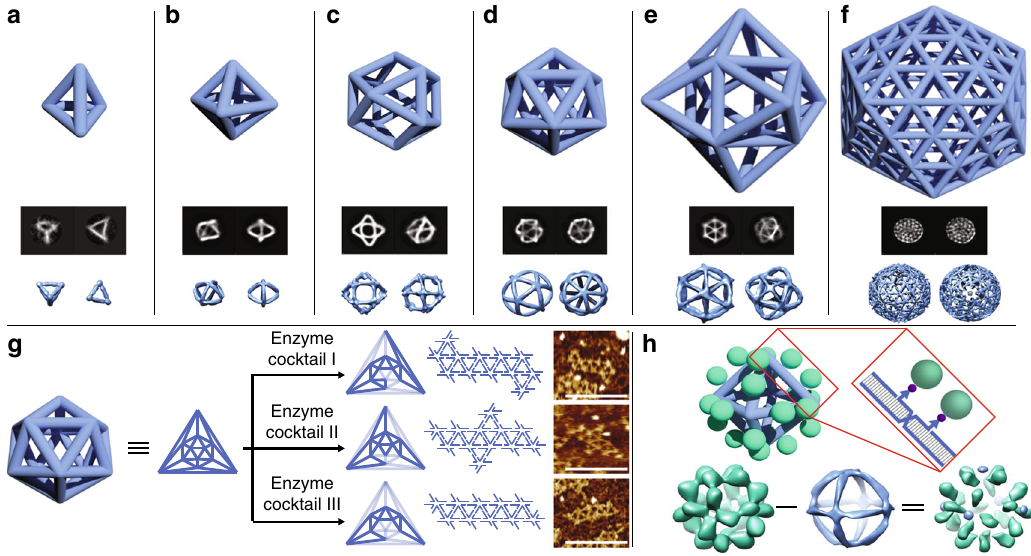
Fig. 4 Wireframe polyhedra. a Tetrahedron with 3-arm vertices. b Octahedron with 4-arm vertices. c Cuboctahedron with 4-arm vertices. d Icosahedron with 5-arm vertices. e Triangulated cube with 6-arm vertices. f Triangulated Buckyball with 5-arm and 6-arm vertices. Panels from top to bottom of a to f : schematic diagrams of polyhedral structures, examples of two-dimensional (2D) classi fi cation results and three-dimensional (3D) maps. g Enzymatic cleavage of an icosahedron. Panels from left to right: 3D con fi guration of an icosahedron, Schlegel diagram of an icosahedron, cleavage patterns (light blue edges depicting the edges to be cleaved) for respective enzyme cocktails and the corresponding AFM images. h Protein display on an octahedron. Top: schematic diagram of the protein display. Zoomed-in view shows the designated sites of biotin groups (purple) binding to the fusion protein (green); Bottom: 3D maps of octahedron with MBP displayed (left), plain octahedron (middle), and the decorated protein molecules (right) resulted from density subtraction. The details of density subtraction are included in Supplementary Note